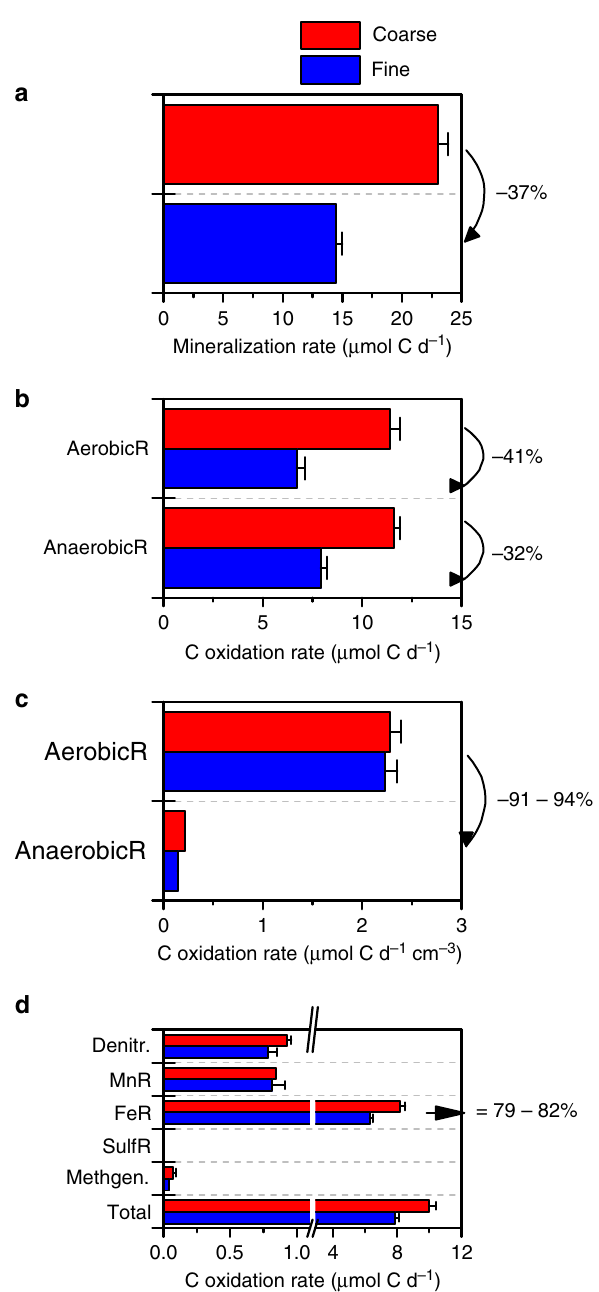
Fig. 2 The effect of particle size-induced variations in the extent of anaerobic microsites on microbial metabolic rates and pathways. a Overall mineralization rate within the reactor, b comparison of the total aerobic and anaerobic respiration rates, c volume-speci fi c aerobic and anaerobic respiration rates, and d contribution of anaerobic respiration pathways to the overall rates. The overall mineralization rates were calculated using linear fi ts, as shown in Fig. 1a. A combination of anaerobic incubations, solid- and solution-phase measurements, and a mass balance approach was used to quantify aerobic and anaerobic respiration rates across the diffusion-limited domain (a detailed description of our approach is provided in the “ Methods ” section). Particle size variations to manipulate the extent of anaerobic microsites are shown in red (coarse = 150 – 250 µ m) and blue ( fi ne = 25 – 45 µ m). Error bars denote the standard error of the mean calculated from four replicate reactors